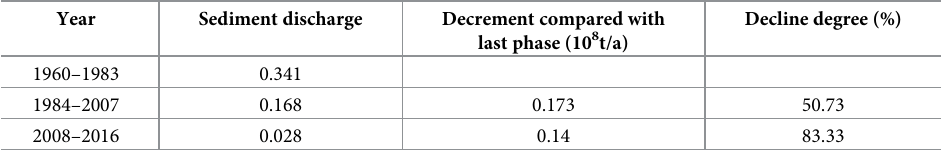
Table 3. Annual average sediment discharge in various phases at Wu Long